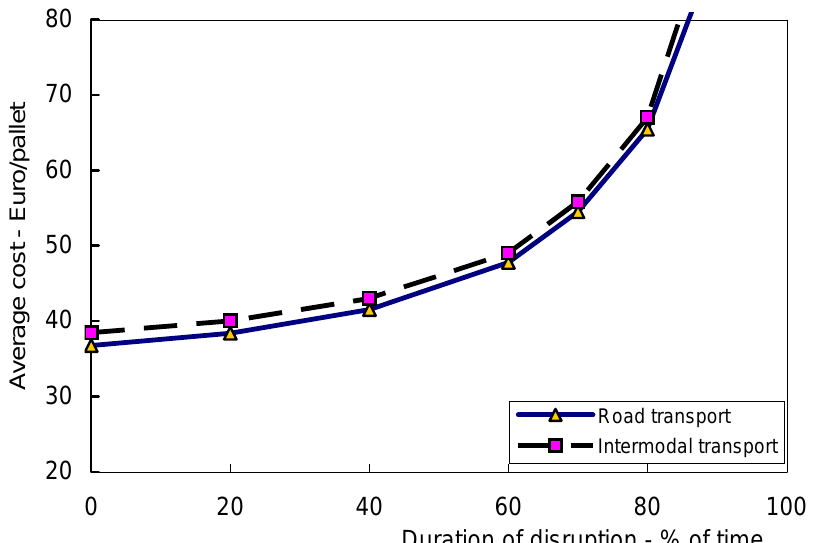
Figure 7. Dependence on the average cost per pallet on the duration of the disruption of the logistics network in a given